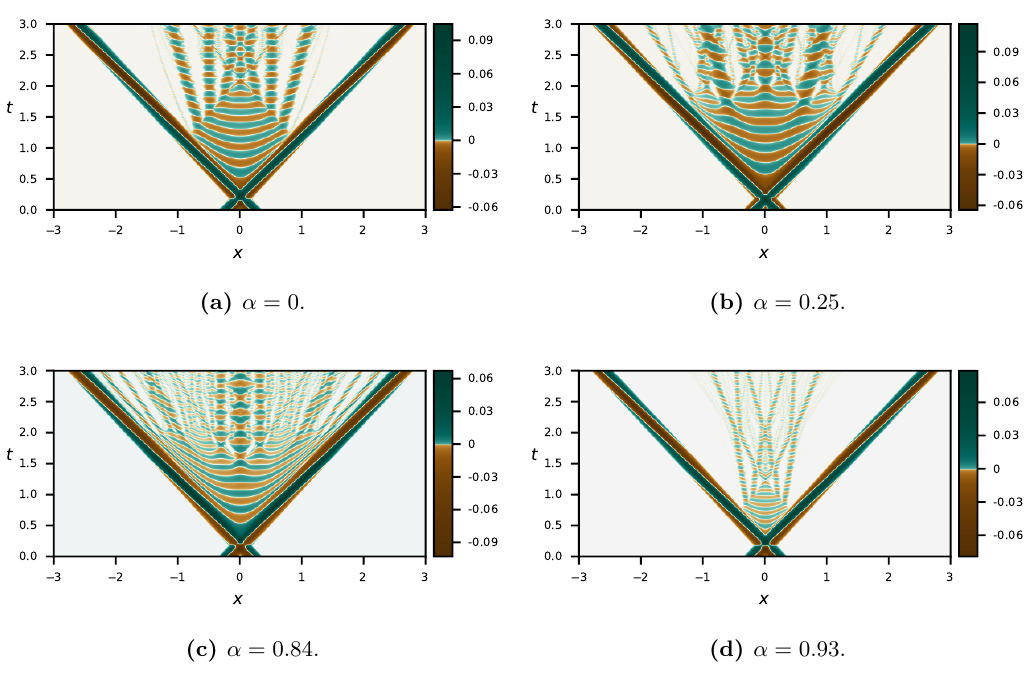
Figure 18 . The scattering process for initial symmetric con(cid:12)gurations containing oscillons with speed V = 0 : 93 and no zig-zag motion of their border and di(cid:11)erent initial phases (cid:11) .